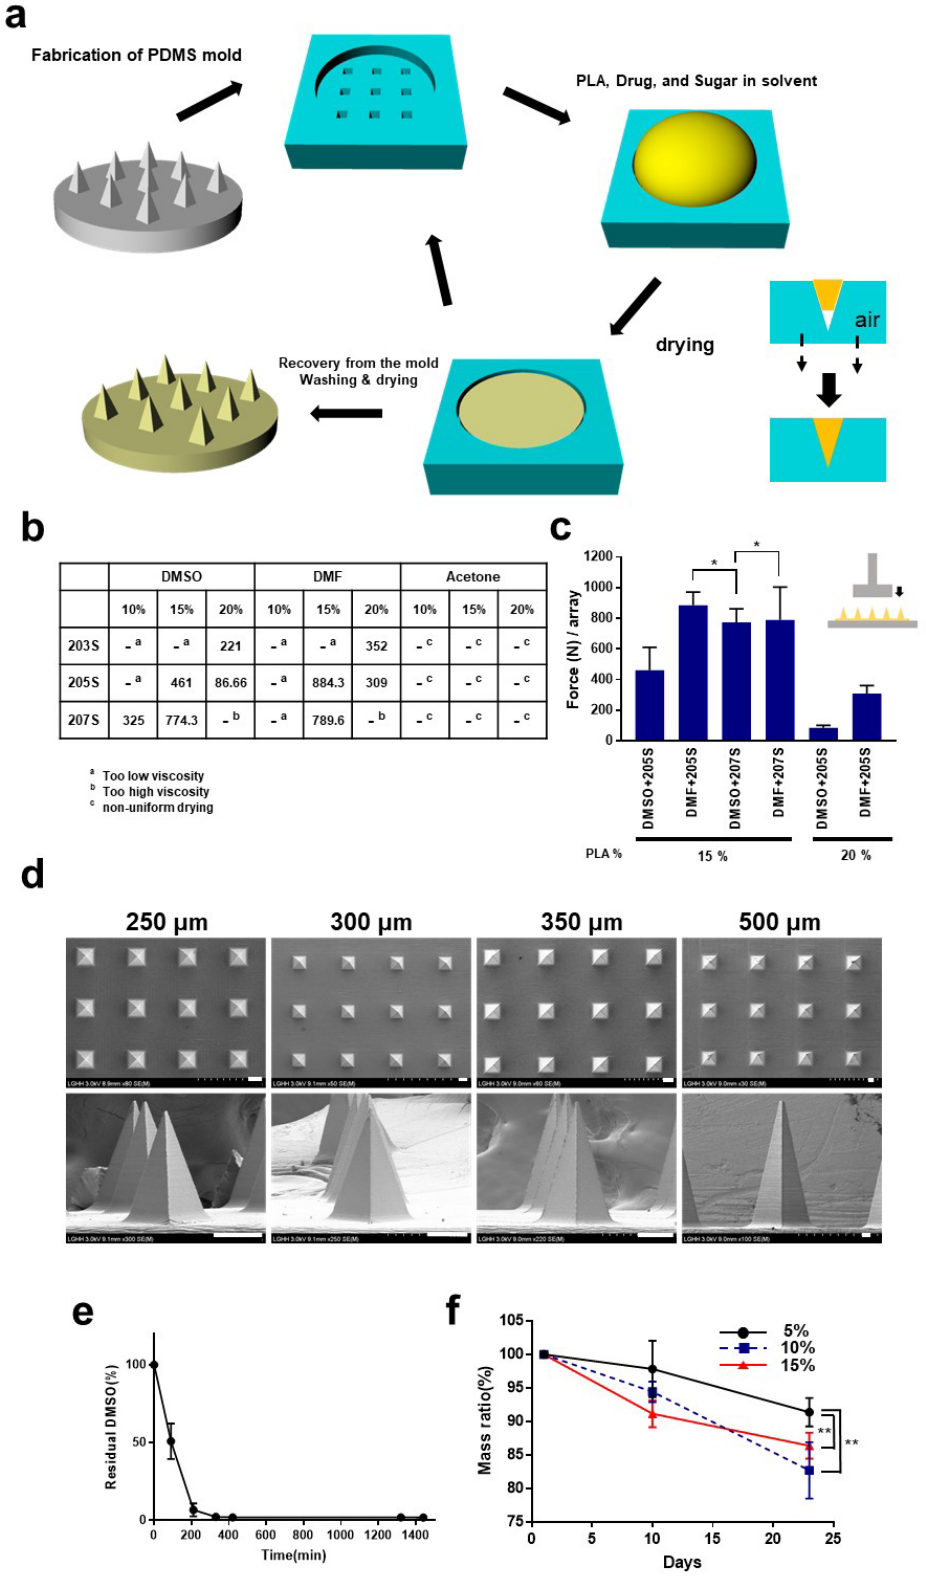
Figure 1. Fabrication and characterization of PLA microneedle based on solvent-casting. ( a ) Schematic diagram of fabrication of PLA microneedle. ( b ) Mechanical strength of microneedle of 300 µ m